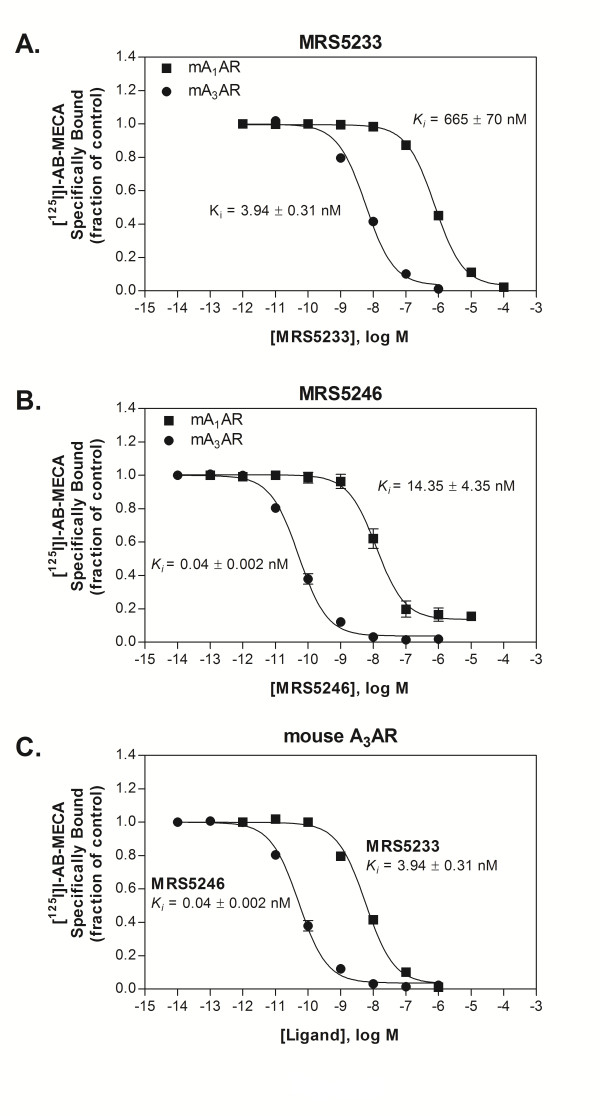
Competition binding assays. Increasing concentrations of MRS5246 or MRS5322 were added to compete for binding with [125I]I-AB-MECA to determine binding affinity, expressed as Ki or Kiapp, to recombinant mARs on HEK293 cell membranes. A & B, Both MRS5246 and MRS5322 bind to the mA3AR with much higher affinity than to the mA1AR. C, binding curves from mA3ARs to compare and show MRS5246 binds with much higher affinity than MRS5322 at the mA3AR.